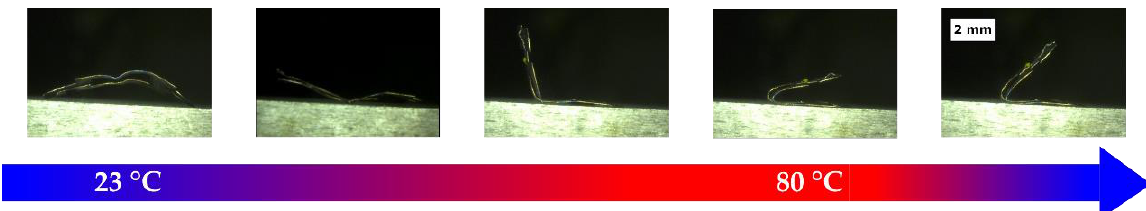
Figure 5. Folding sequence of a mechanically deformed SMA folding microactuator at room temperature. The memory shape can be recovered by heating on a hot plate above the austenite finish temperature.